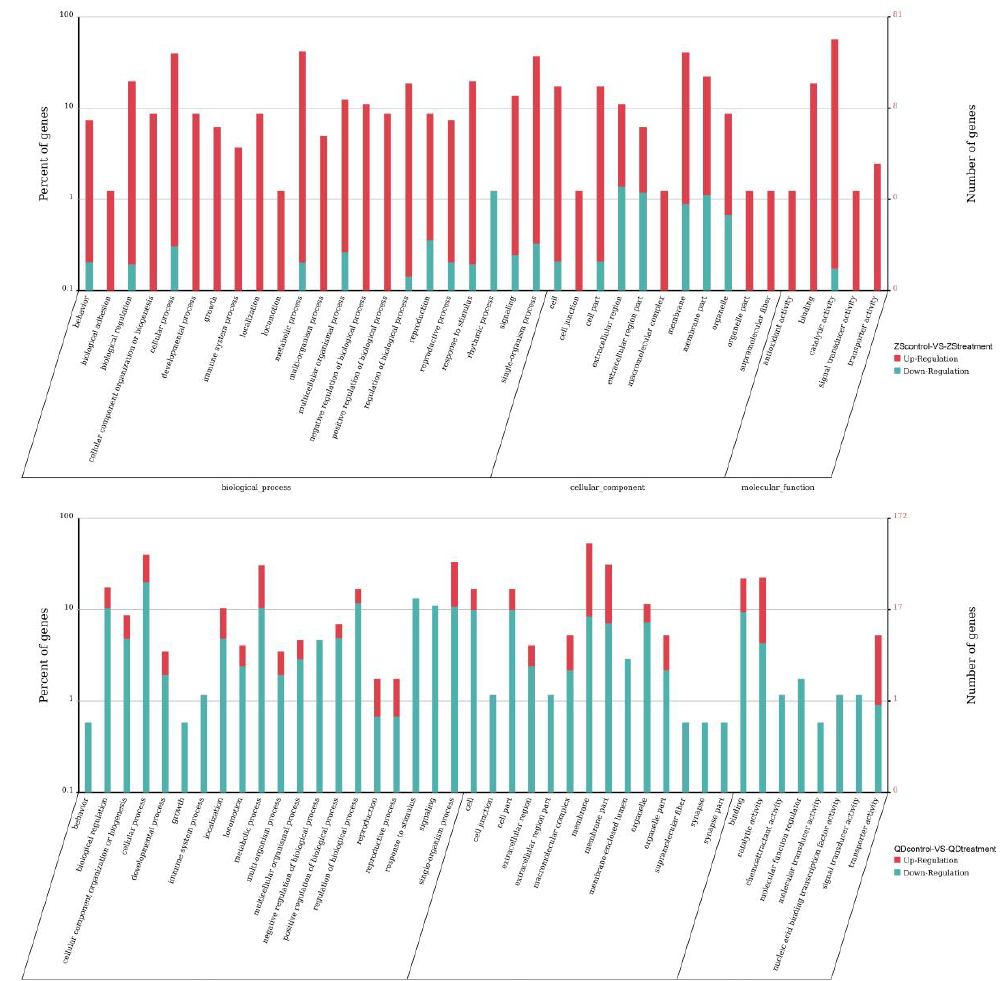
Figure 6. Results of the enrichment analysis of GO terms of differentially expressed unigenes of each population exposed to thermostress (ZS control : Zhoushan population at 20 °C; ZS treatment : Zhoushan population at 28 °C; QD control : Qingdao population at 20 °C; QD treatment : Qingdao population at 28 °C). The differentially expressed unigenes in each pair (ZS control -VS-ZS treatment , QD control -VS-OQ treatment ) were then used to identify the enriched KEGG pathways. There were 154 and 174 pathways found to be differentially regulated between the Zhoushan and Qingdao populations exposed to the same thermal stress. However, the results also indicated that 18 and 4 pathways were significantly enriched in the Zhoushan and Qingdao populations, respectively (Q ≤ 0.05; see Figure 7 for the top 20 pathway enrichment statistics). Differentially expressed unigenes in the Zhoushan population were predominately associated with the pathways of the metabolism (ko00520 and ko00531) and the digestive system (ko04972 and ko04974). In contrast, the differentially expressed unigenes in the Qingdao population were enriched for pathways associated with genetic information processing (ko04141), immune (ko05202 and ko05110) and environmental information processing (ko04010).